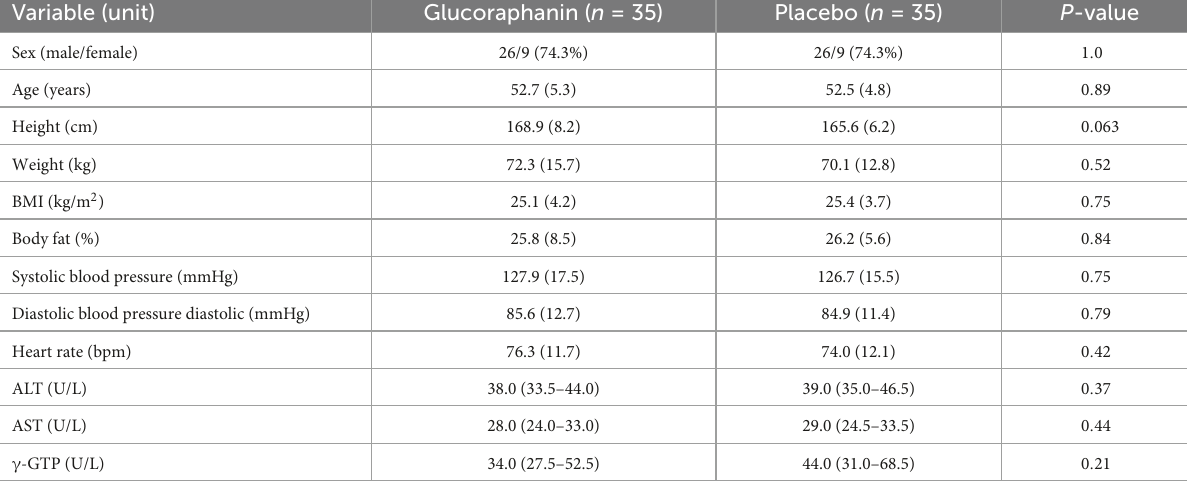
TABLE 1 Participant